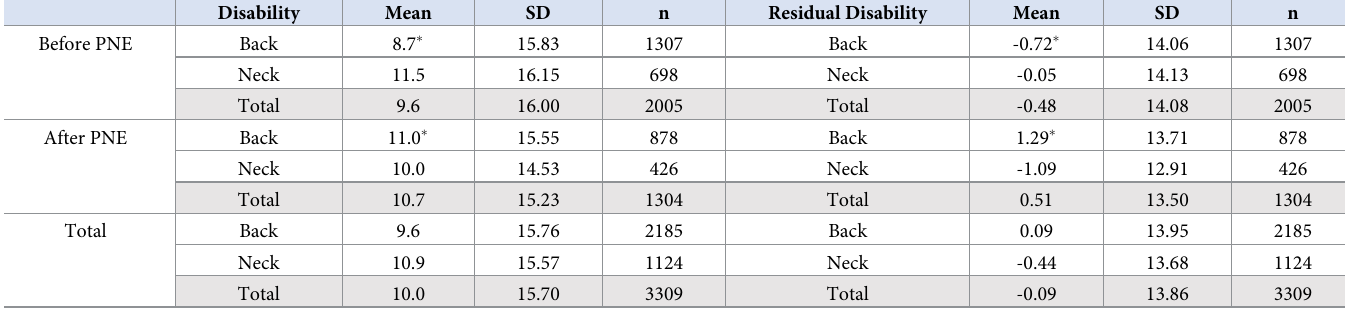
� Indicates statistically significant